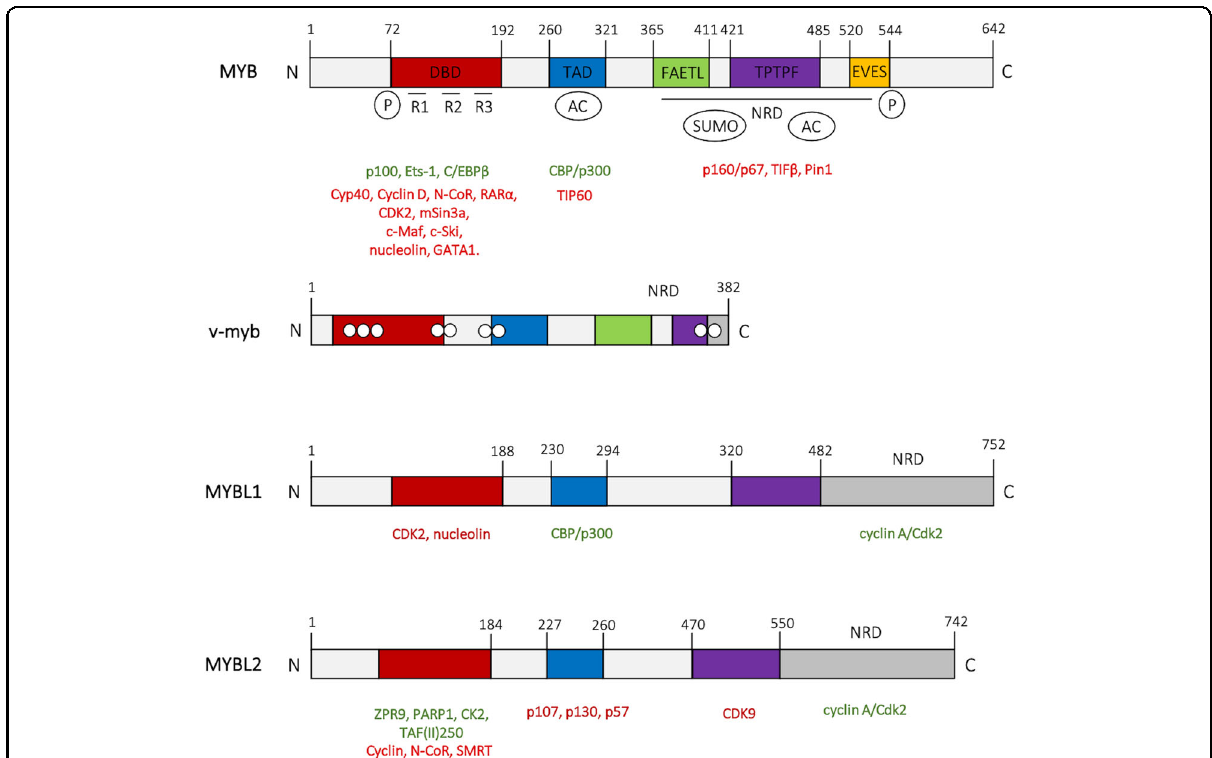
Fig. 1 MYB family members ’ protein structures. The v-myb DNA-binding domain is equivalent to amino acids 72 – 192 of MYB, except the introduction of four point mutations (I91N, L106H, V117D, and I181V) and the addition of six amino acids in N-terminal region derived from the retroviral Gag polyprotein 187 . The white dots on AMV v-myb structure indicate point mutations important for the ability of v-myb to transform cells 188 . MYB co-activators are listed in green and the co-repressors are listed in red. The DNA-binding domain (DBD) is comprised of three repeats (R1, R2, and R3). It is the binding site for a number of proteins including p100, PARP, c-Ski, N-CoR, RAR, Cyp40, C/EMPbeta, SMRT, and mSin3A, as depicted; the central transactivation domain (TAD) is the interaction site for CBP/p300; the negative regulatory domain (NRD) extends from the FAETL motif to the EVES peptide sequence (involved in intramolecular and intermolecular protein – protein interactions) and includes the binding sites for p160/p67, Pin1, and TIF1beta 150,189 – 193 . The post-translational modi fi cations include phosphorylation (P), acetylation (AC), and sumoylation (SUMO) 194 – 197